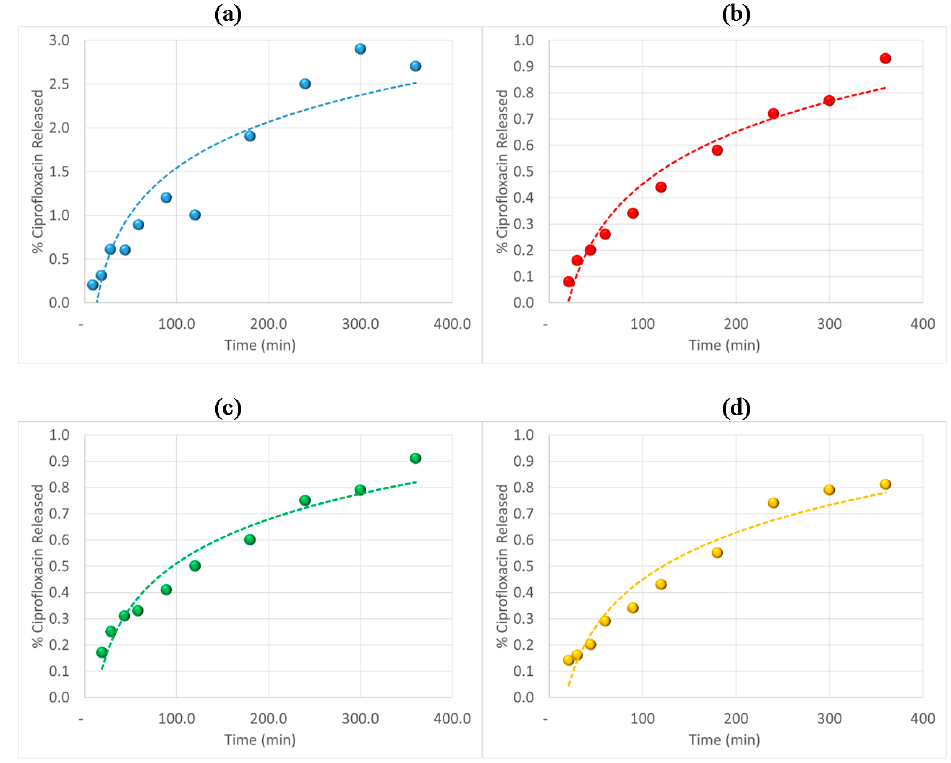
Figure 17. Ciprofloxacin release rate from polymer networks synthetized by RAFT copolymerization. Samples: ( a ) G315; ( b ) G316; ( c ) G317; and ( d ) G318. Processes 2017 , 5 , 26